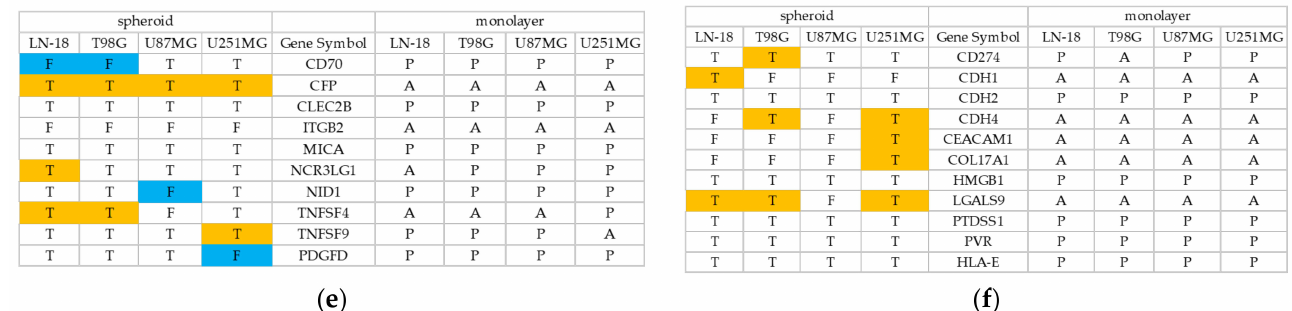
Figure 4. Differential gene expression between monolayer-culture cells and spheroids derived from GBM cell lines. We analyzed gene expression, GSC markers ( a ), ECM markers ( b ), chemokines ( c ), chemokine receptors ( d ), NK cell activation receptor ligands ( e ), and NK cell inhibitory receptor ligands ( f ) in the monolayer culture using Transcriptome Analysis Console (TAC). For each probe set on each array, the Microarray Suite 5.0 (MAS5) algorithm yields a detection call: Absent (A), Present (P), or Marginal (M), which indicates whether the specific mRNA is detectable. The detection call in MAS5 is based on a non-parametric statistical test (Wilcoxon signed-rank test) of whether significantly more perfect matches show more hybridization signals than their corresponding mismatches. We also analyzed gene expression using Detected Above Background (DABG) values. The microarray data were normalized by the robust multiarray average method; a probe set was considered expressed if >50% samples had DABG values below the DABG threshold ( p < 0.05). The expression status was described as True (T) or False (F), which indicates whether the specific mRNA was detectable. The significantly differentially expressed genes were determined by expression analysis performed using ANOVA. The orange cells indirectly indicate upregulation, where the expression status changed from Absent, which was analyzed by detection calling, to True, which was analyzed by DABG values; the blue cells indirectly indicate downregulation, where the expression status changed from Present to